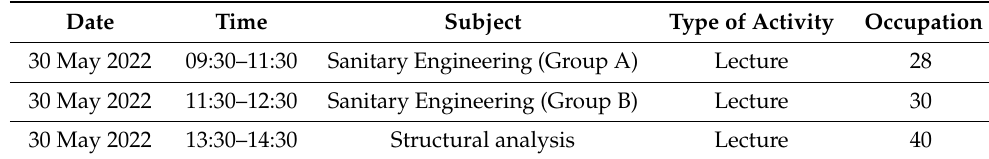
Table 6. Schedule of the teaching activities in classroom 110.